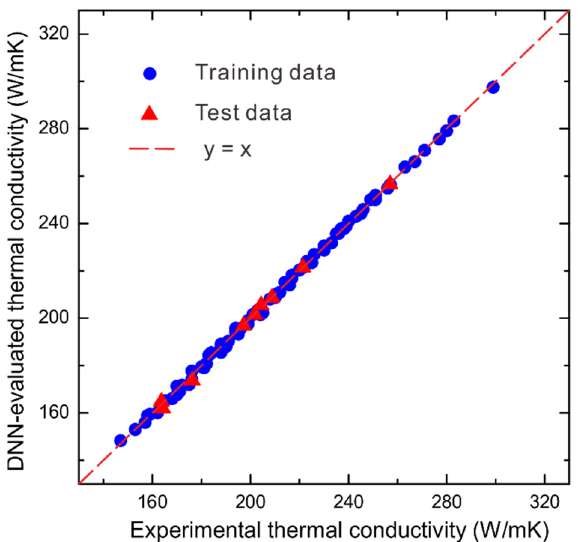
Figure 4. The comparisons of training and test thermal conductivities by fold 3 with the measured ones for WC-Ag system.